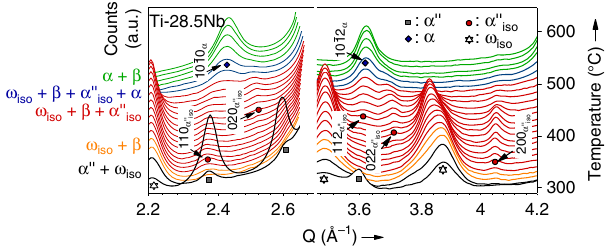
Fig. 6 Formation of α ″ iso . In situ synchrotron X-ray diffraction patterns of Ti – 28.5 Nb heated at 10 °C min − 1 showing the formation of α ″ iso above martensite reversion and its gradual evolution into α during further